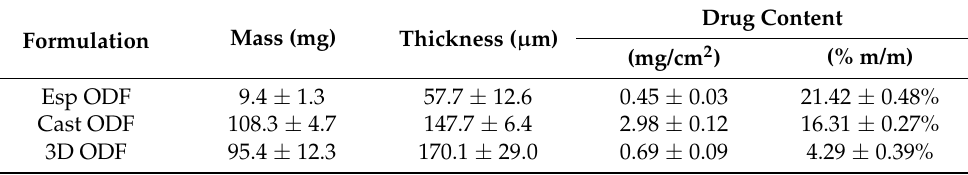
Table 3. Physical properties and uniformity of content of aripiprazole in ODF formulations ( n = 10); film size 6 cm 2 .